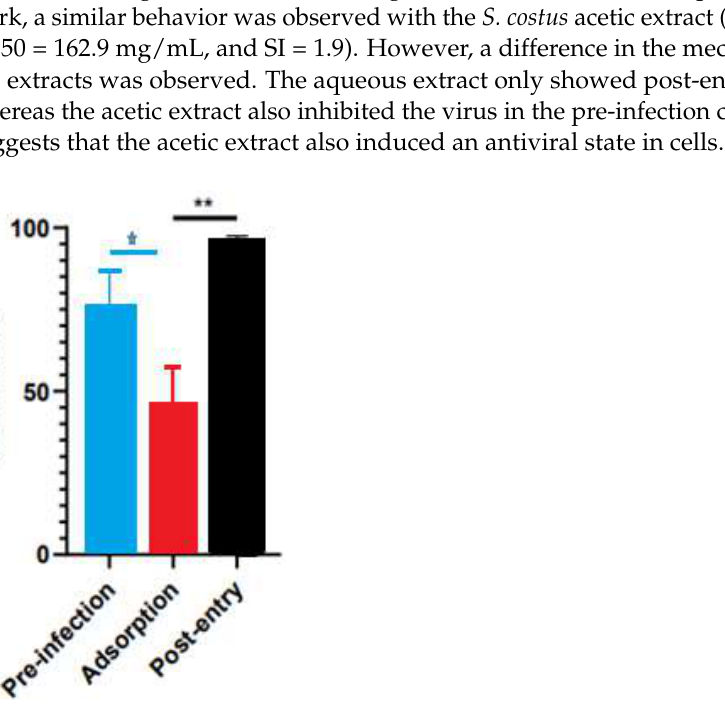
Figure 5. Time-of-addition assay results for Saussurea costus acetic extract. Vero cells were infected at MOI 1.5 and incubated with the extract at different times during the infection, as described in the Materials and Methods. After 48 h post-infection, the virus genome was quantitated in the superna- tant via qPCR. The percentage of inhibition was determined as the ratio between treated and un- treated infected cells. Data are expressed as mean +/− SD for n = 3. Statistical analysis was performed using one-way ANOVA, followed by multiple comparisons testing with significance indicated as * p < 0.05, ** p < 0.01 . indicated as * p < 0.05, ** p <